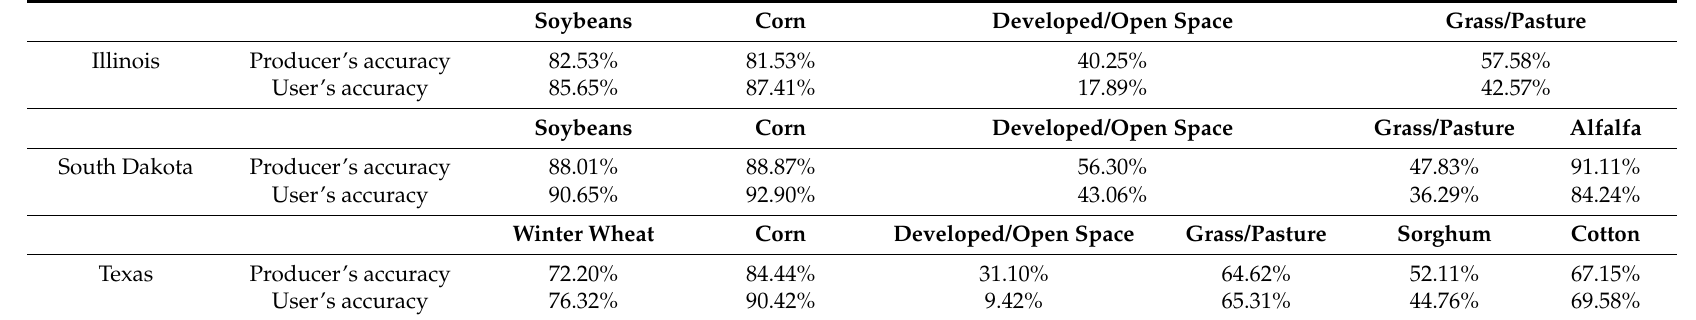
Table 6. Mean producer and user accuracies of classification based on LE-SAM-R+RF method.